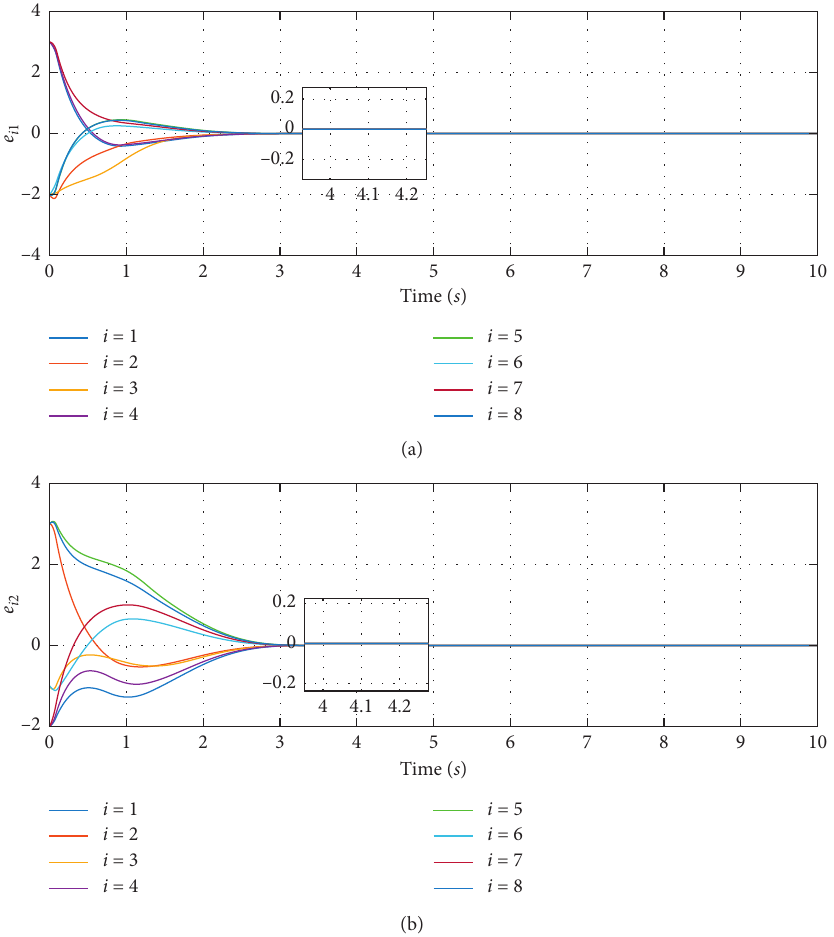
Figure 5: Pictures (a) and (b) reveal the evolution of v and 2, respectively.